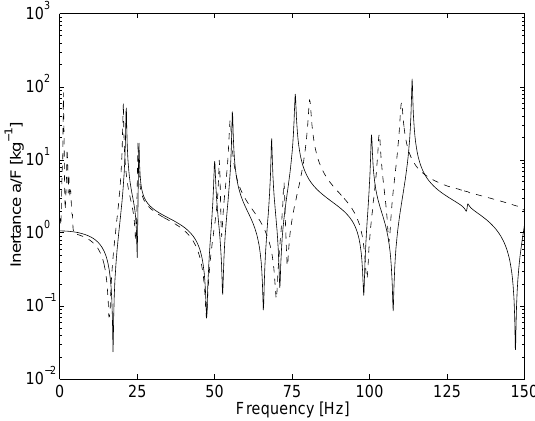
Fig. 8. FRF of the coupled structure: measured (–) vs. predicted (- - -) using static expansion and identified mode shapes. In Fig. 8, an FRF measured on the modified structure is compared with the corresponding synthesized FRF.